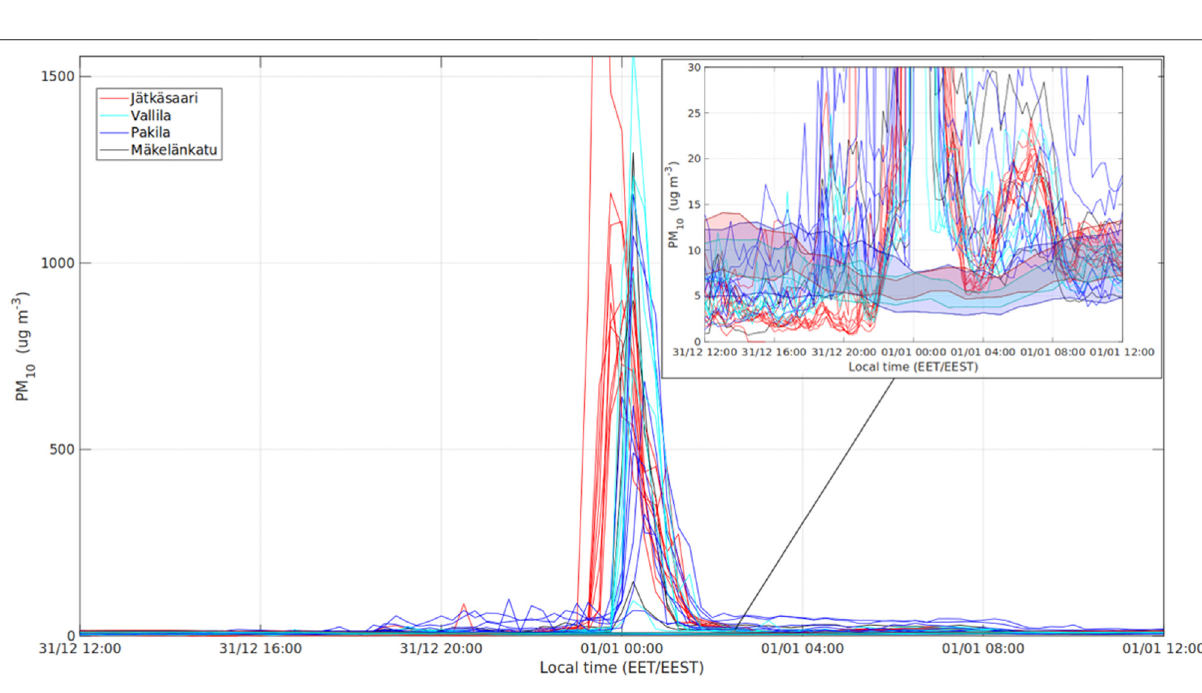
Frontiers in Environmental Science |